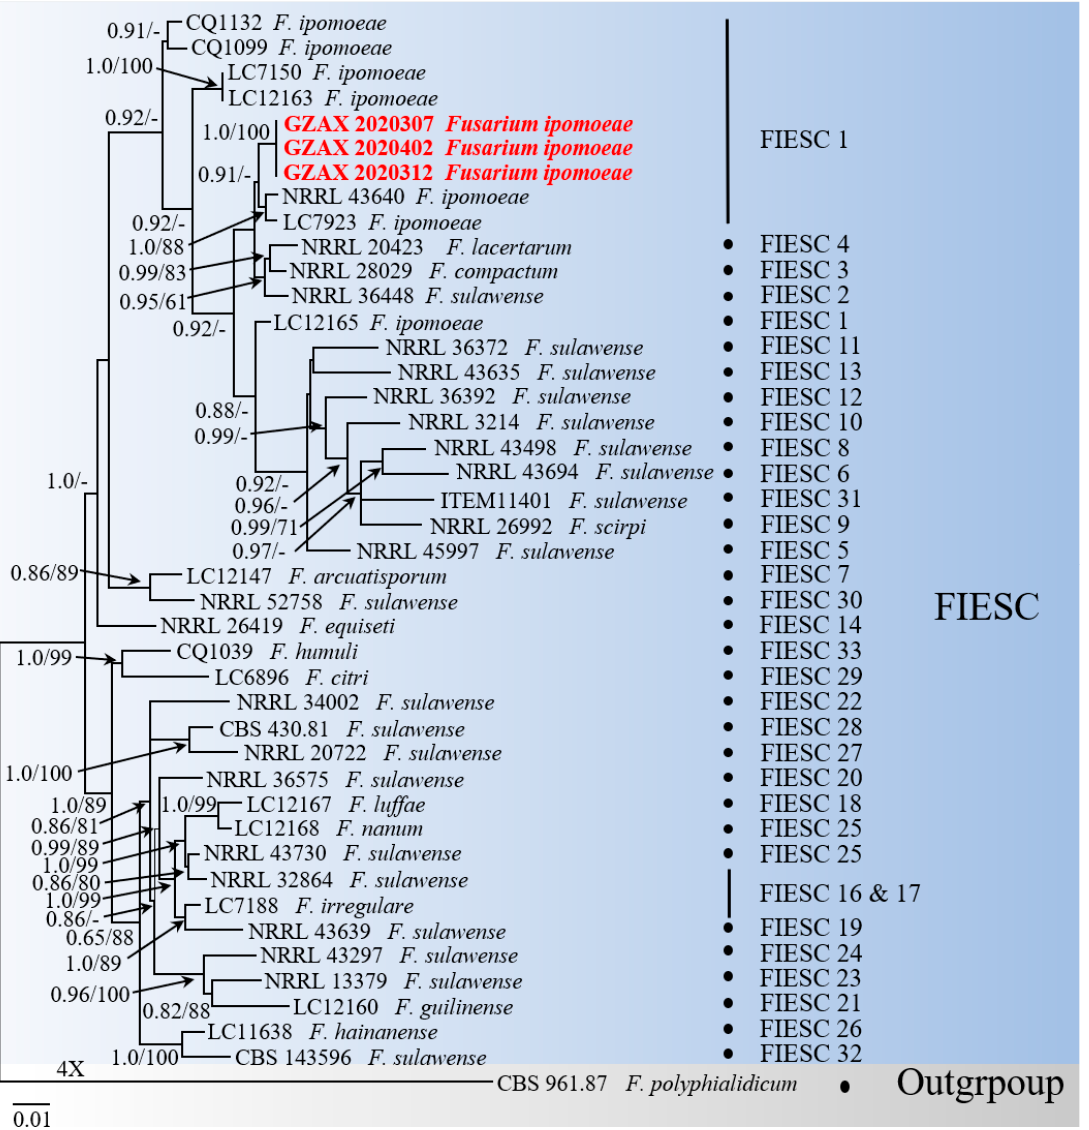
Figure 3 . Phylogenetic tree was constructed using strains of Fusarium incarnatum – equiseti complex (FIESC), based on ITS, EF–1 α , CAM , RPB1 , and RPB2 loci. MrBayes posterior probabilities (PP > 65) and ML bootstrap (BS > 60%) support values were showed at the nodes (PP/BS).